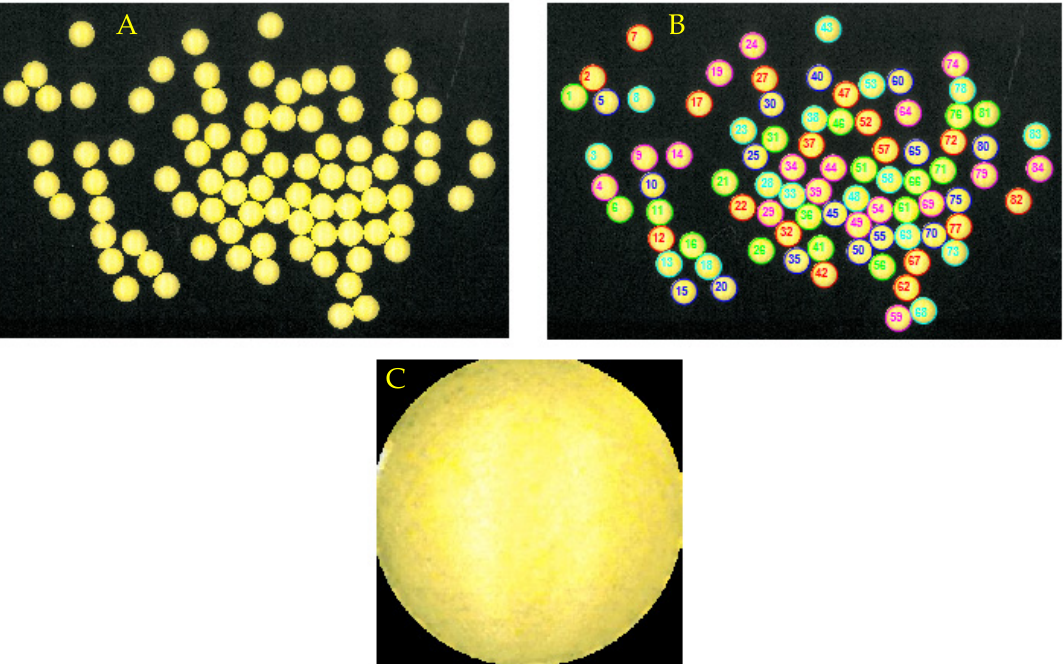
Figure 2. Scanned image of the coated tablets ( A ), segmentation of the individual coated tablets in the scanned image ( B ), and an example of a segmented image of one of the tablets ( C ).